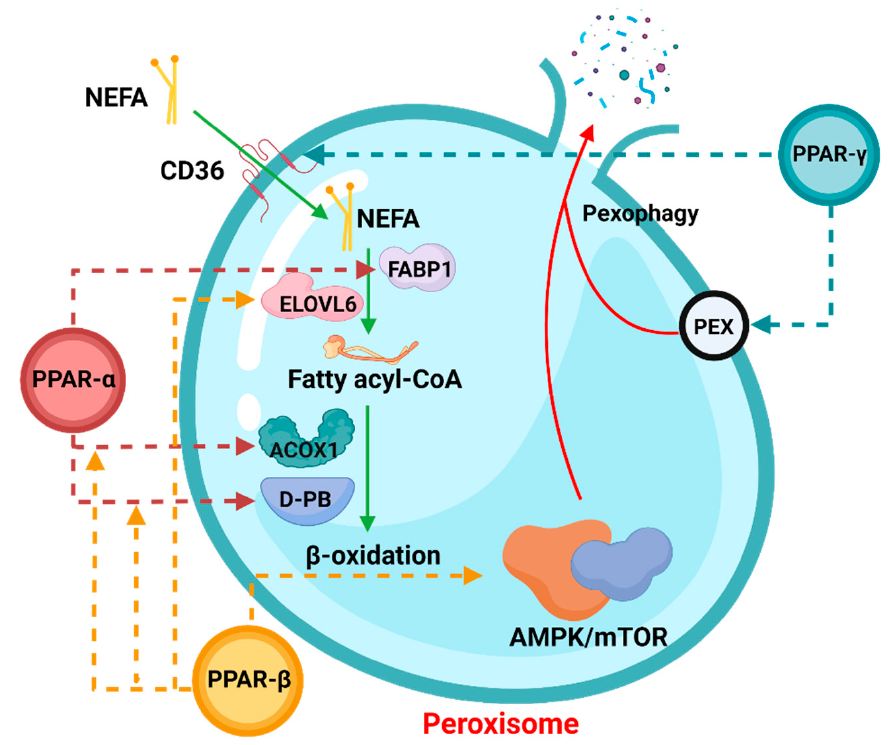
Figure 3. The role of PPARs in peroxisomal β -oxidation.